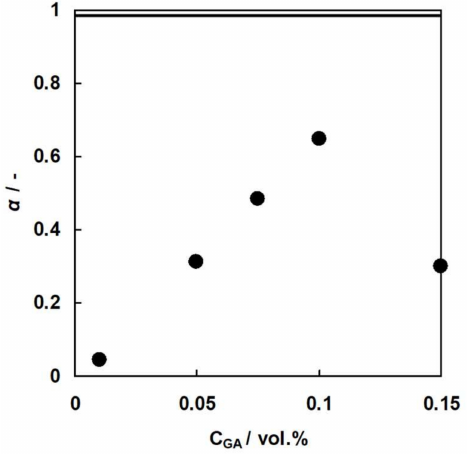
Figure 14. The selectivity coefficient, α , of C-HF membranes as a function of GA concentration. Solid circles, C-HF membranes. Solid line,